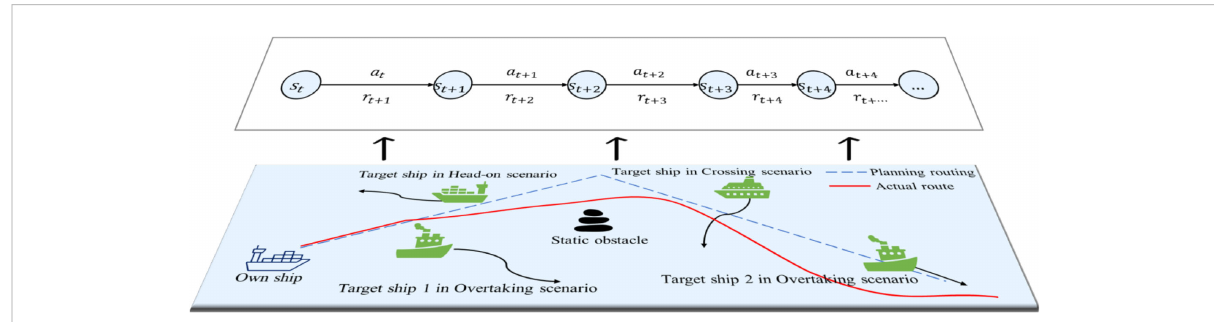
FIGURE 2 Collision avoidance of autonomous ships in a continuous state space scenario. Graph fl ow of upper and lower layers: the lower layer is the schematic diagram of the physical scene. In the scene, there is a static obstacle and four target ships (dynamic obstacles). Four target ships form the head-on, crossing, and overtaking scenarios with the own ships. In the upper layer, st represents the state at time t, at represents the anti- collision action at time t, rt+1 represents the reward from st to st+1 by action at at time